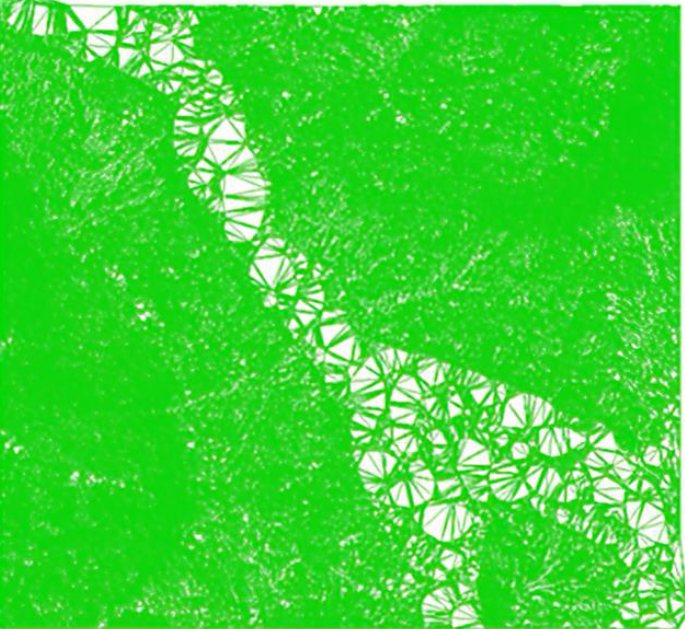
Figure 16. Digital terrain model of the research area—TIN grid, draft version, view from above. On the basis of the pre-formed TIN grid, the vectorized contours of mountains and the slopes of embankments were projected onto the created surface. The final version of the DTM is shown in Figures 17 and 18.